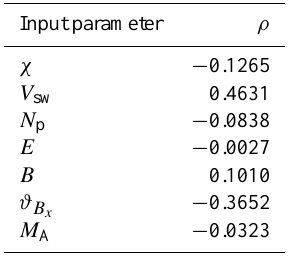
Table 2. Pearson correlation coefficient between Pc3 ind and input parameters for 2002–2007. Only data with χ < 90 ◦ and Kp < 4 0 are